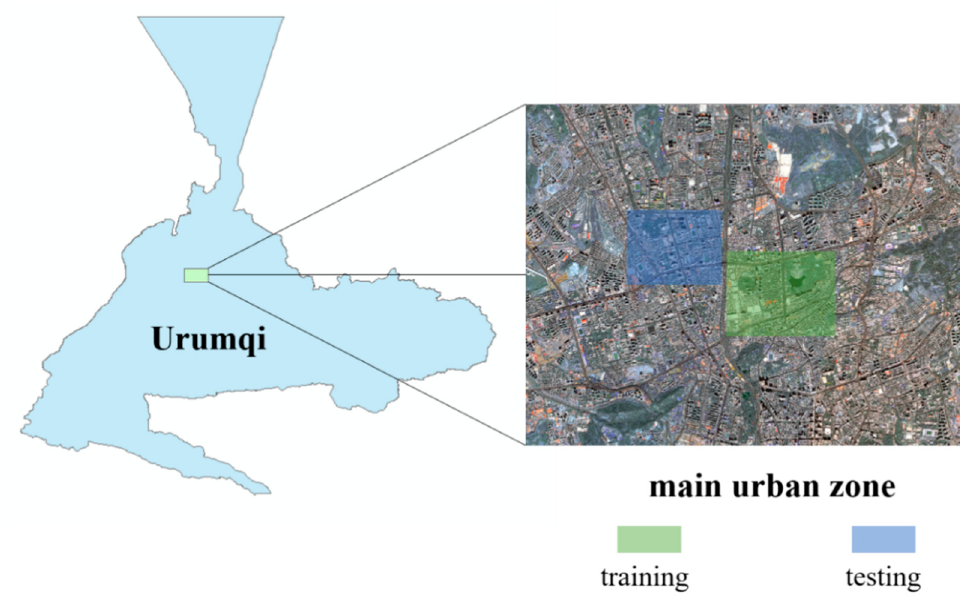
Figure 4. Gaofen-2 data sets.